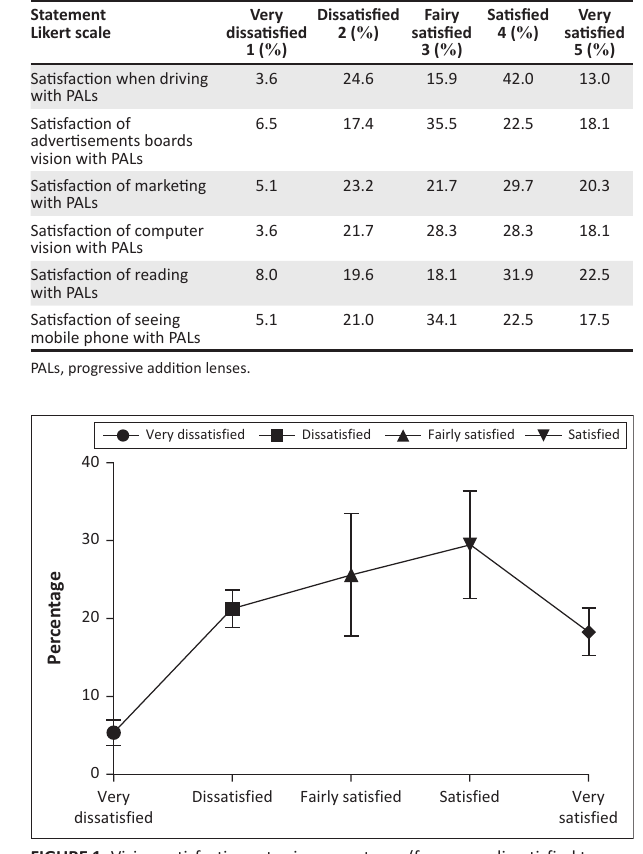
FIGURE 1: Vision satisfaction rates in percentages (from very dissatisfied to very